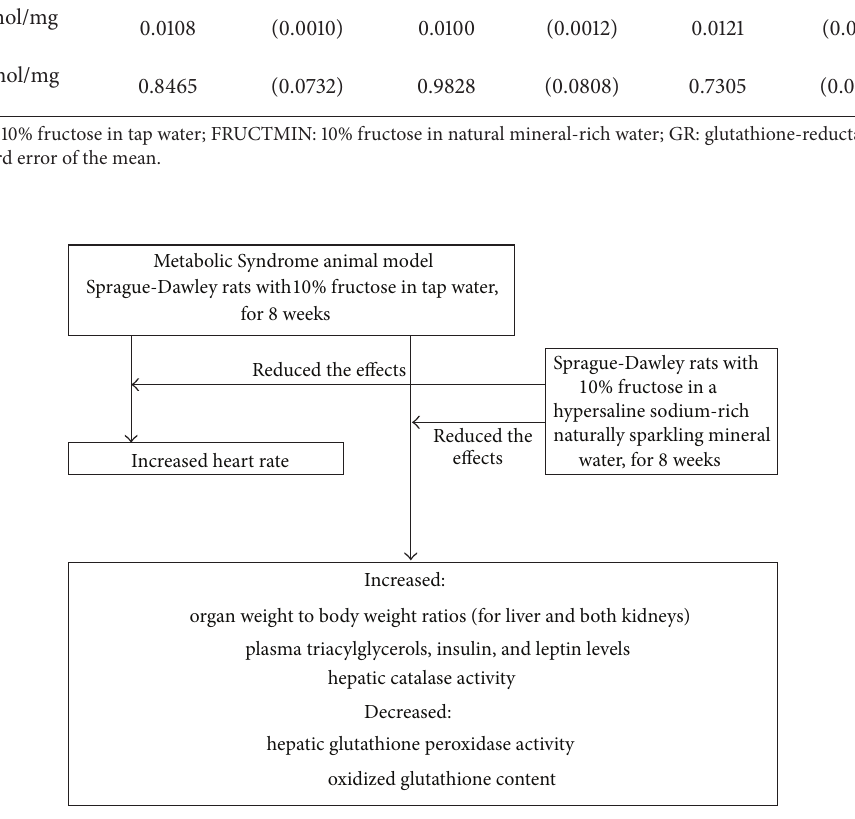
SOD activities by 10% fructose ingestion in tap water